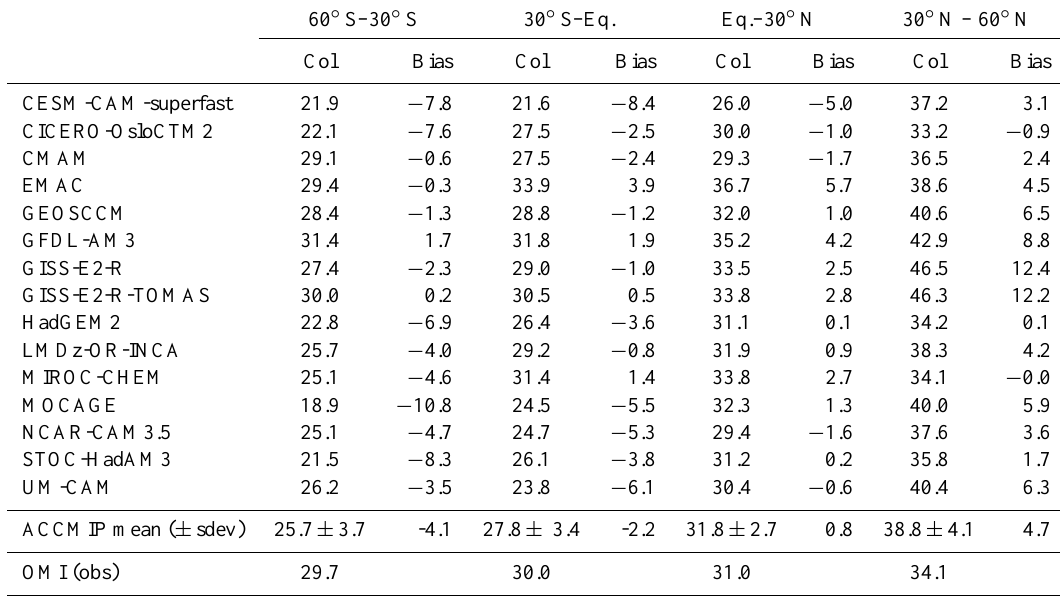
Table 4. Tropospheric ozone column and bias (DU) for the Hist 2000 simulation of the ACCMIP models vs. the OMI climatology for different latitude bands.